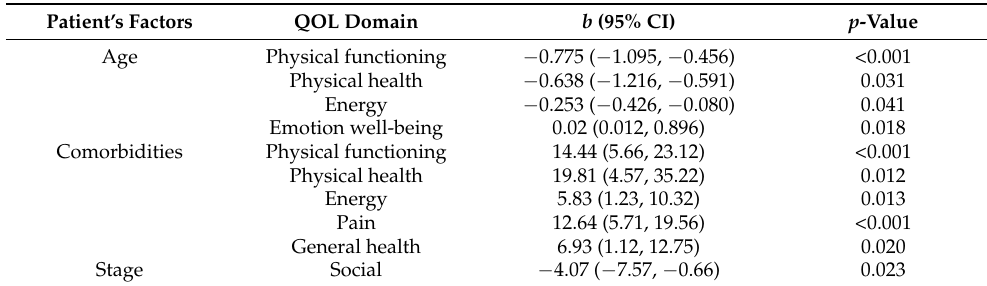
Table 9. Association of patient’s sociodemographic and clinical factors with QOL Domain based on SF-36 questionnaires.